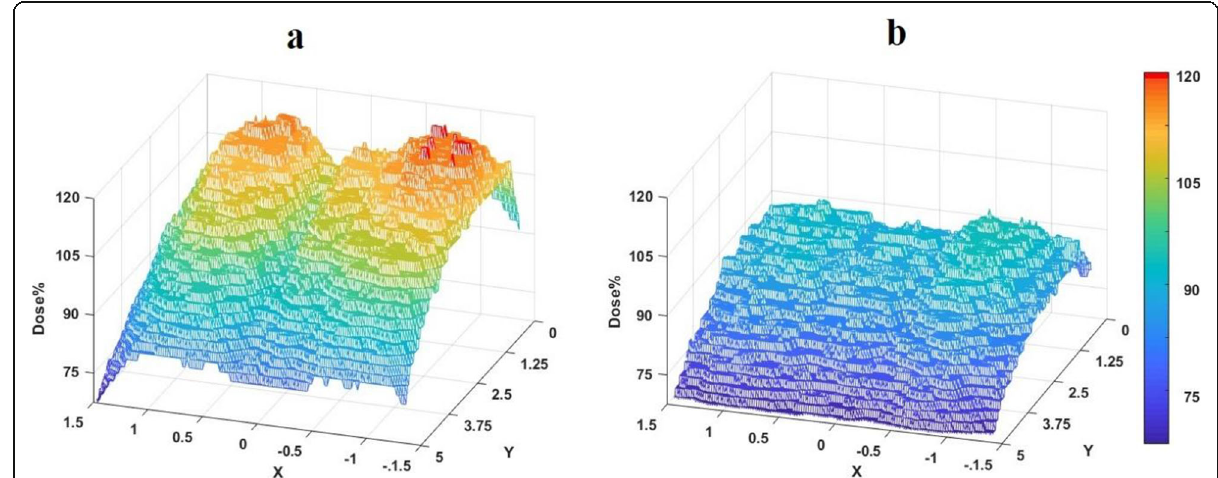
Fig. 4 EBT-3 relative dose profiles of the area of 3cm × 5 cm within the field at the level of crowns a with and b without dental